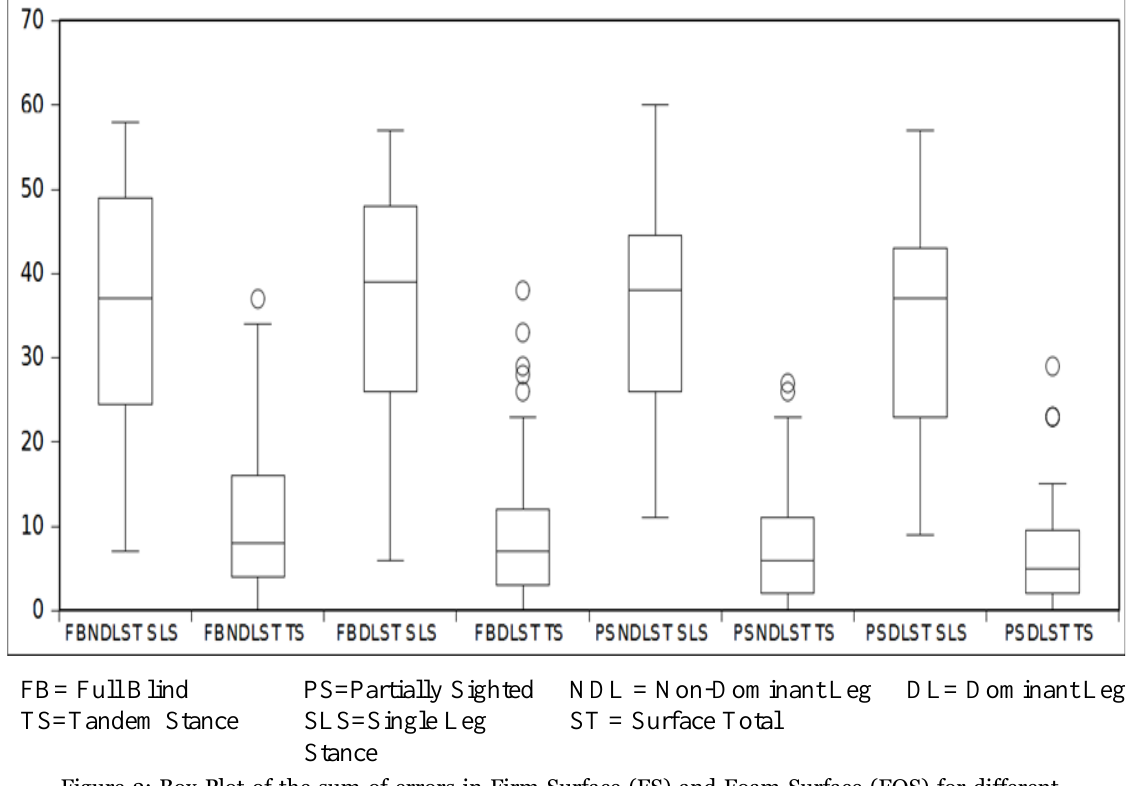
Table 3: BESS score in Non-Dominant and Dominant Leg support